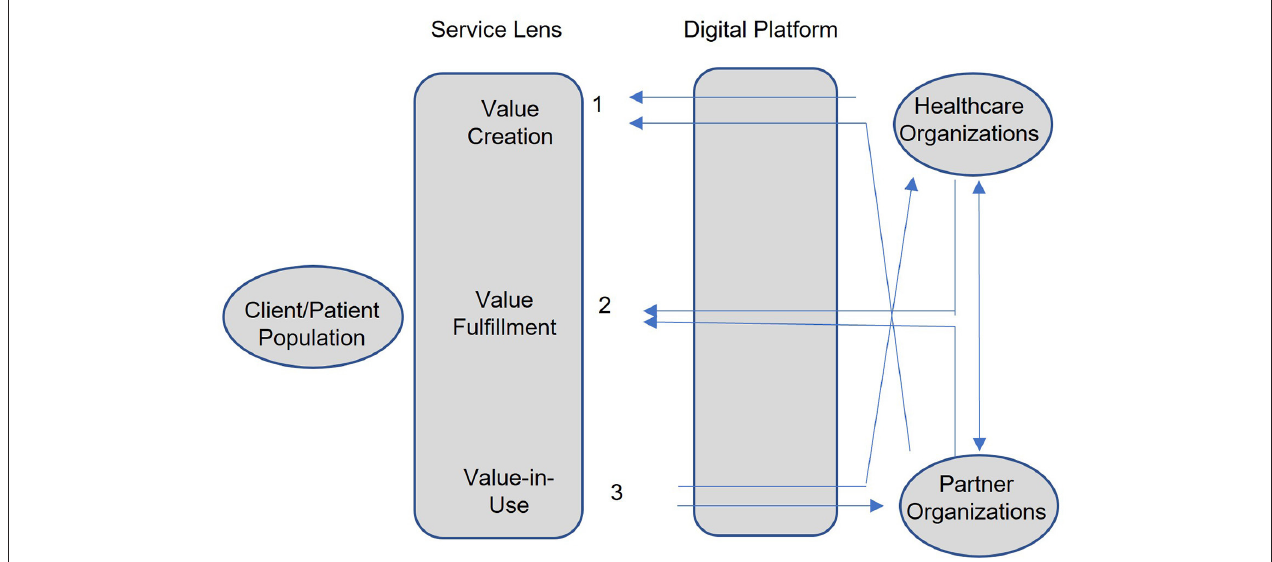
FIGURE 1 | Community strategies using value lens and digital